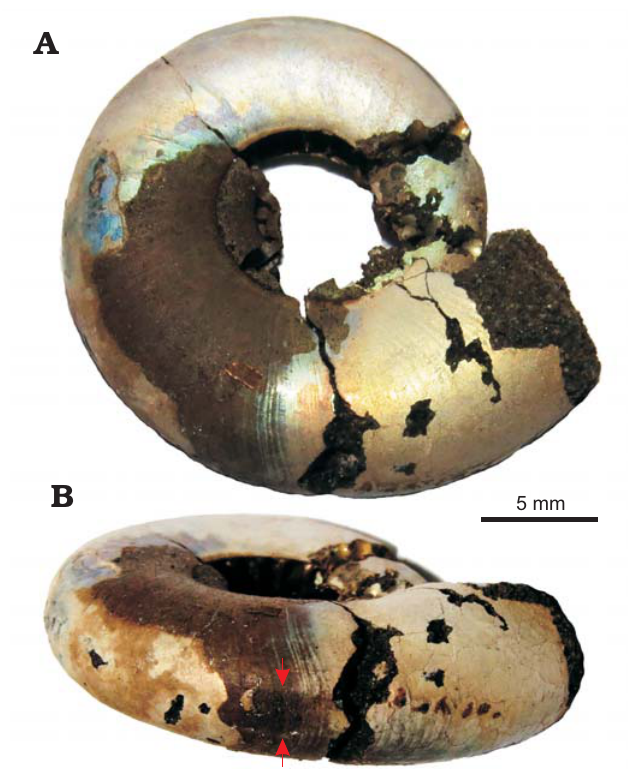
Fig. 13. Phosphatic layer on the surface of the craspeditid ammonite Kachpurites fulgens (Trautschold, 1861) shell from the Late Volgian, K. fulgens Zone, Eganovo locality, Moscow region, Central Russia. Specimen (MSU 118/17) with fragments of a thin brown phosphate layer on the sur- face of the shell (presumably remnants of the periostracum) in lateral ( A ) and ventral ( B ) views. A narrow dark band is visible on the venter